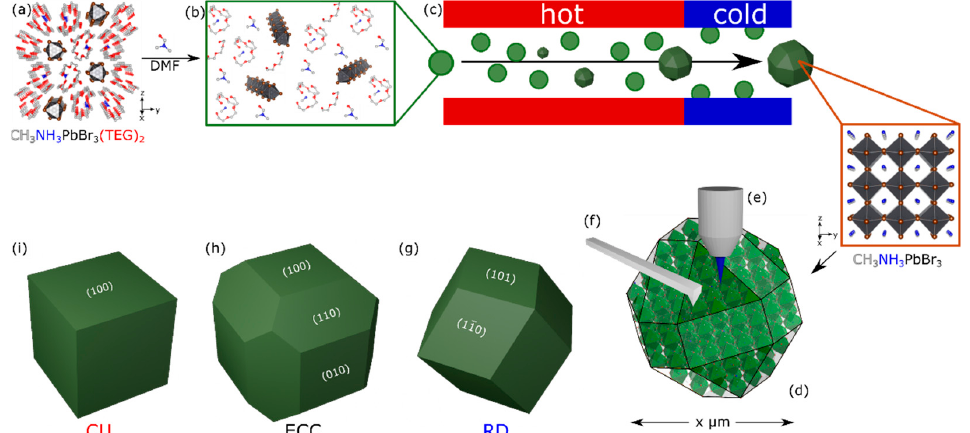
Figure 1. ( a ) Structure of the hybrid perovskite single-source precursor [43]. ( b ) Structural break-up of [PbBr 3 ] −∞ chains by DMF addition. ( c ) Injection of a spray of the precursor into the aerosol setup and transformation into micrometer sized particles of shape-controlled CH 3 NH 3 PbBr 3 single-crystals by inverse temperature crystallization. ( d ) Individual particles are investigated by spatially resolved methods such as μ -photoluminescence (PL). ( e ) μ -transient absorption spectroscopy (TAS) and (f) Kelvin-probe force microscopy (KPFM). The three hybrid perovskite microcrystal morphologies covered in this paper and the set of symmetry-equivalent surfaces in Miller-index notation: (g) rhombic dodecahedron (RD) , (h) edge cut cube (ECC) , and (i) cube (CU).